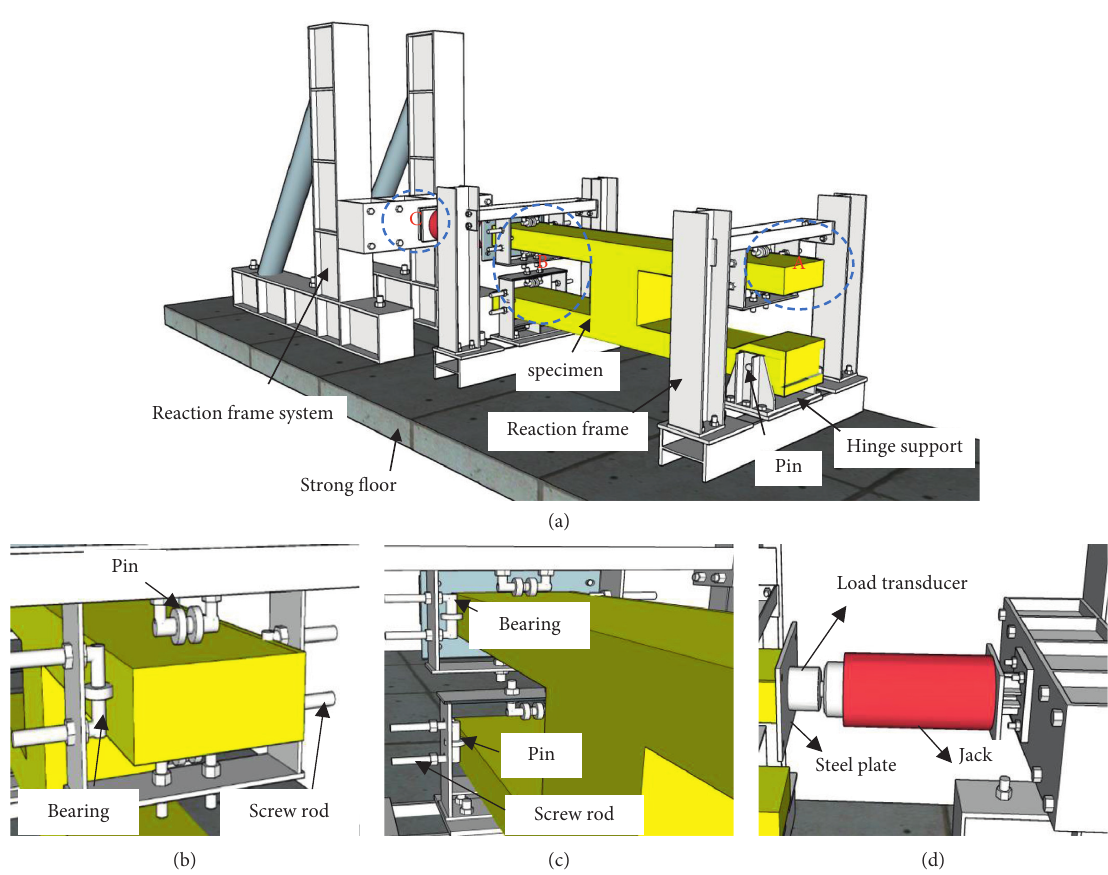
Figure 6: Design of loading device diagram. (a) Overall diagram of the designed test loading device. (b) Detailed diagram of area A. (c) Detailed diagram of area B. (d) Detailed diagram of area C.